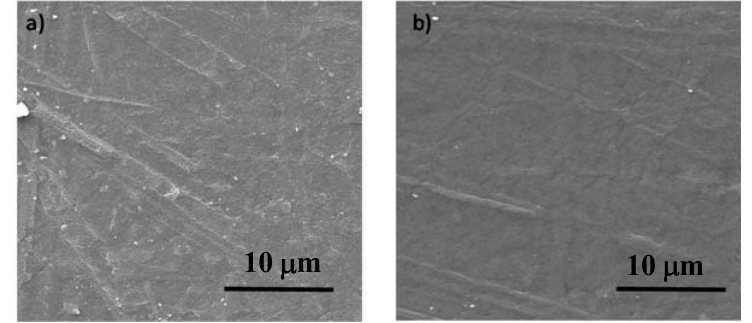
Figure 1. Scanning Electron Microscopy (SEM) micrographs of the PDMS surface: ( a ) pristine material; ( b ) after plasma cleaning with 250 W.